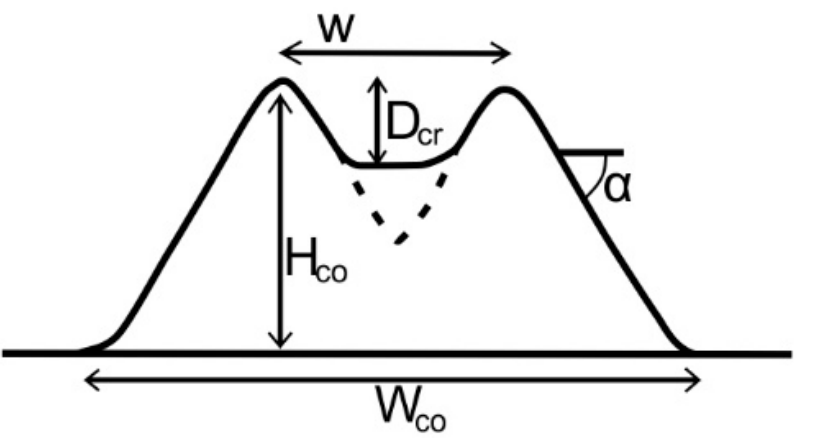
Figure 3. Relationships between volcanic parameters. W cr = crater width, D cr = crater depth, H co = cone height, W co = basal width of cone, α = maximum slope angle (based on [20]). From the 2000s, digital terrain models (DTM) became the bases for morphometric research. With the help of these, Favalli and co-authors [26] examined the parameter changes due to lava flows in scoria cone fields and stated that the height of scoria cones settling on a volcanic slope (layered or shield volcano side) should be calculated differently. Fornaciai et al. [27] examined the parameters of 21 volcanic areas with 2, 10, and 30 m resolution